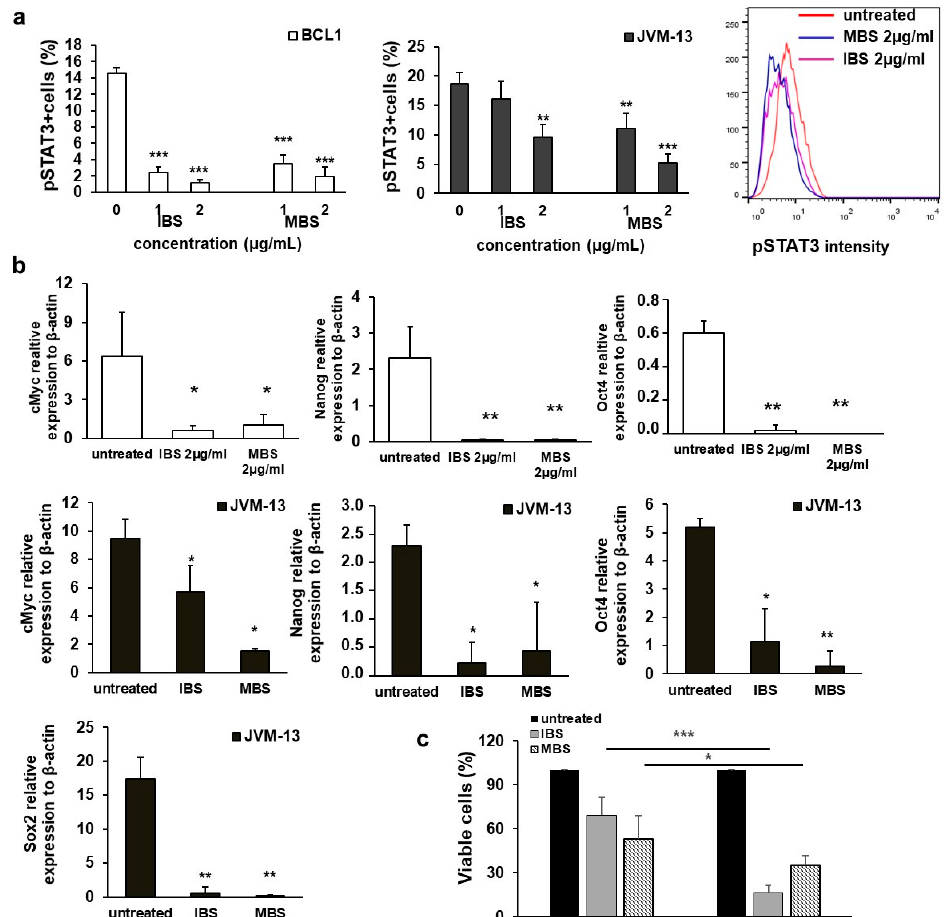
Figure 5. Treatment with IBS and MBS attenuates the expression of pSTAT3- and STAT3-regulated genes in BCL1 and JVM-13 cells. ( a ) Percentages of pSTAT3 positive BCL1 and JVM-13 cells determined by flow cytometry 24 h after treatment with IBS and MBS and representative histograms of pSTAT3 expression in JVM-13 cells. ( b ) mRNA expression of c-Myc, Nanog, and Oct4 in BCL1 cells and c-Myc, Nanog, Sox2 and Oct4 in JVM-13 cells treated with IBS and MBS quantified by RT-PCR. ( c ) BCL1 cells’ survival after 24 h growth in the presence of IBS and MBS, with or without the addition of Jak2 inhibitor AG490 (tyrphostin), determined by MTT assay. Data are presented as the mean ± SD. * p < 0.05, ** p < 0.01, *** p < 0.001.